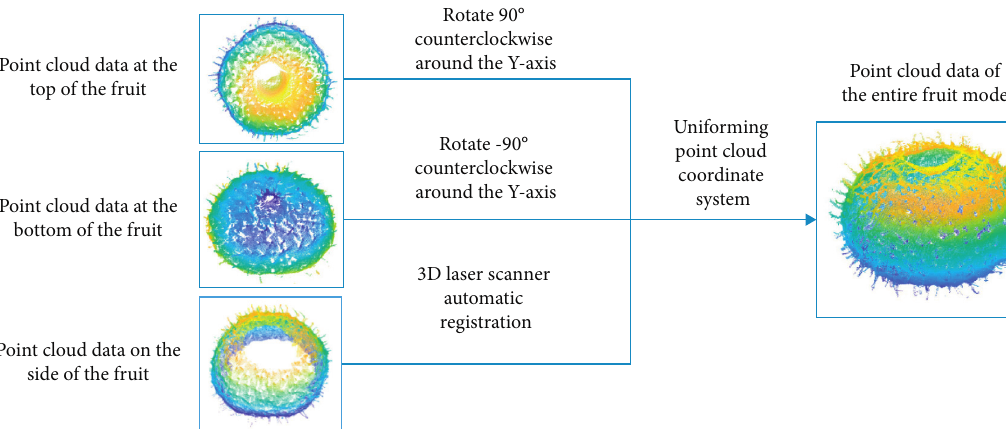
Figure 3: Registering the entire model of fruit through point cloud data from different coordinate systems.